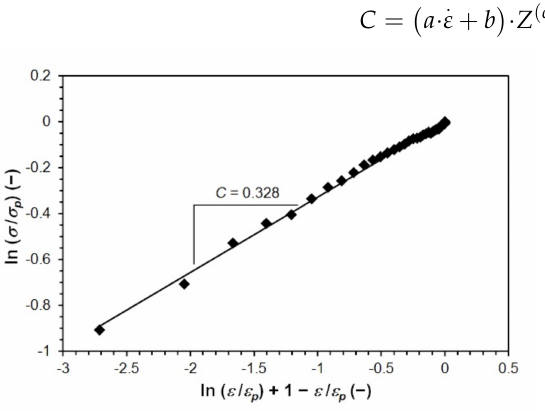
Figure 6. Determining the constant C for steel B (temperature 1000 ◦ C, strain rate 20 s − 1 ).